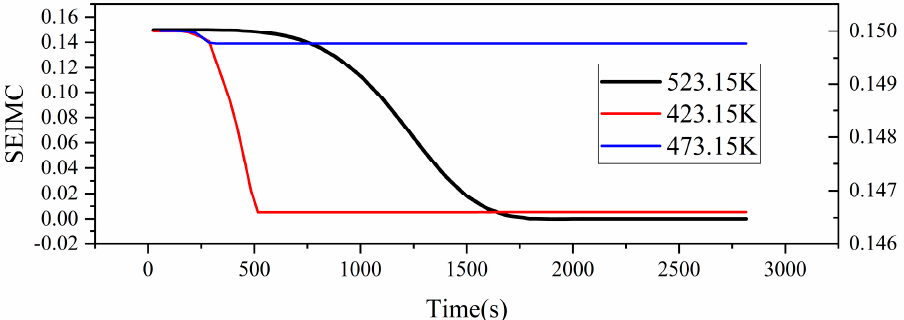
Figure 6. Conformational curves for changes in cell composition of SEI films at different temperatures in tests 4, 5, and 6.